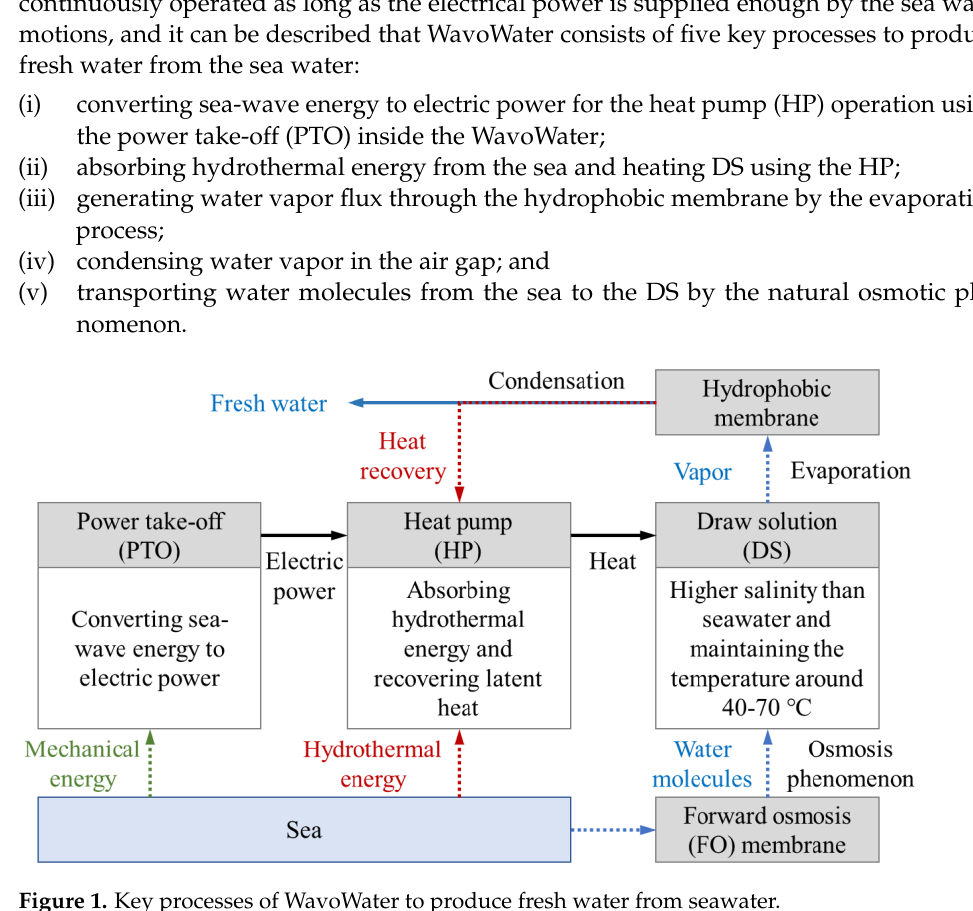
Figure 1. Key processes of WavoWater to produce fresh water from seawater.